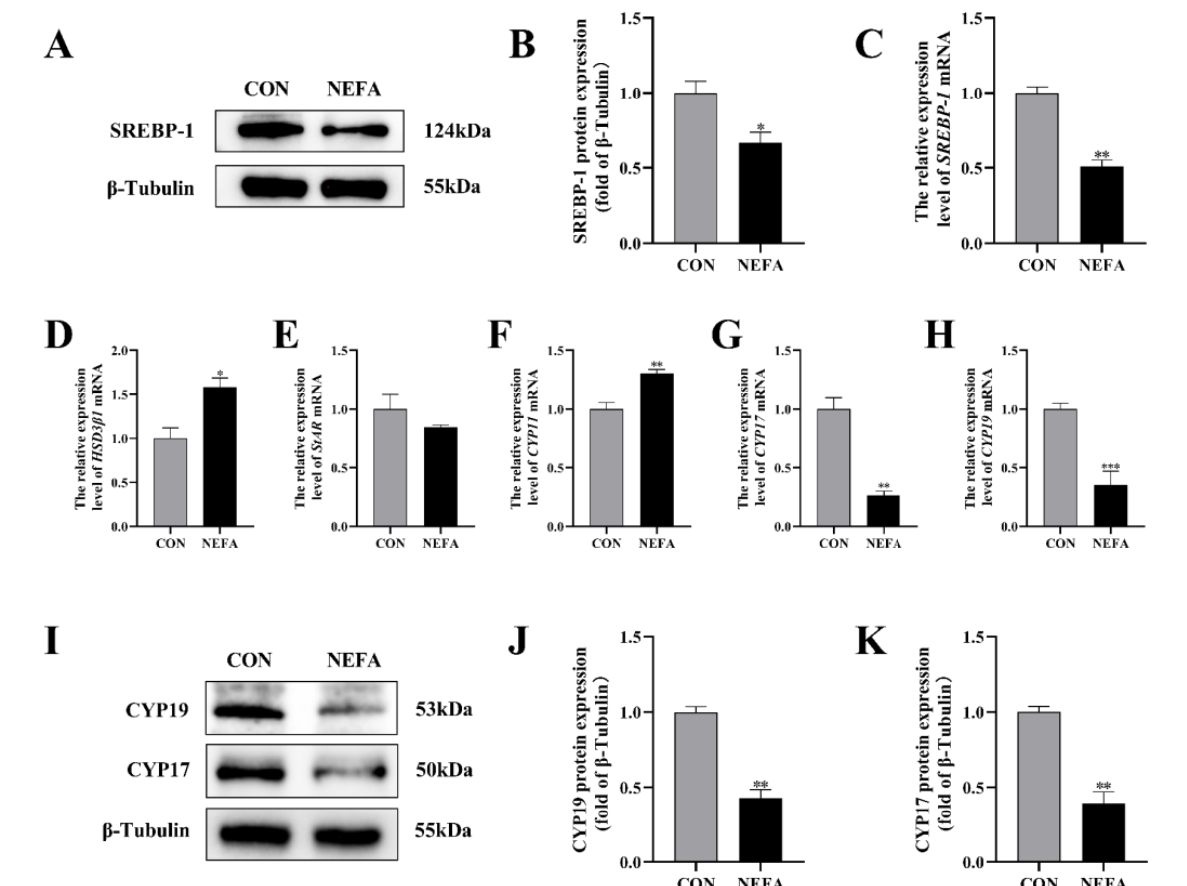
Figure 4. The effects of NEFA on the biosynthesis of transport and synthesis of steroid hormones in BGCs. BGCs were treated with or without 1.2 mM NEFA for 24 h. ( A – C ) SREBP − 1 protein and gene expression in BGCs. ( D – F ) Effects of NEFA on gene expression levels on HSD3 β 1, StAR, and CYP11. ( G – K ) CYP17 and CYP19 protein and gene expression in BGCs. The quantification of the relative protein levels (performed using Image J) is shown under the band (protein/ β − Tubulin). This experiment was repeated 3 times, and data are expressed as mean ± standard errors of the mean (SEM), * p < 0.05; ** p < 0.01; *** p < 0.001; ns, not significant.